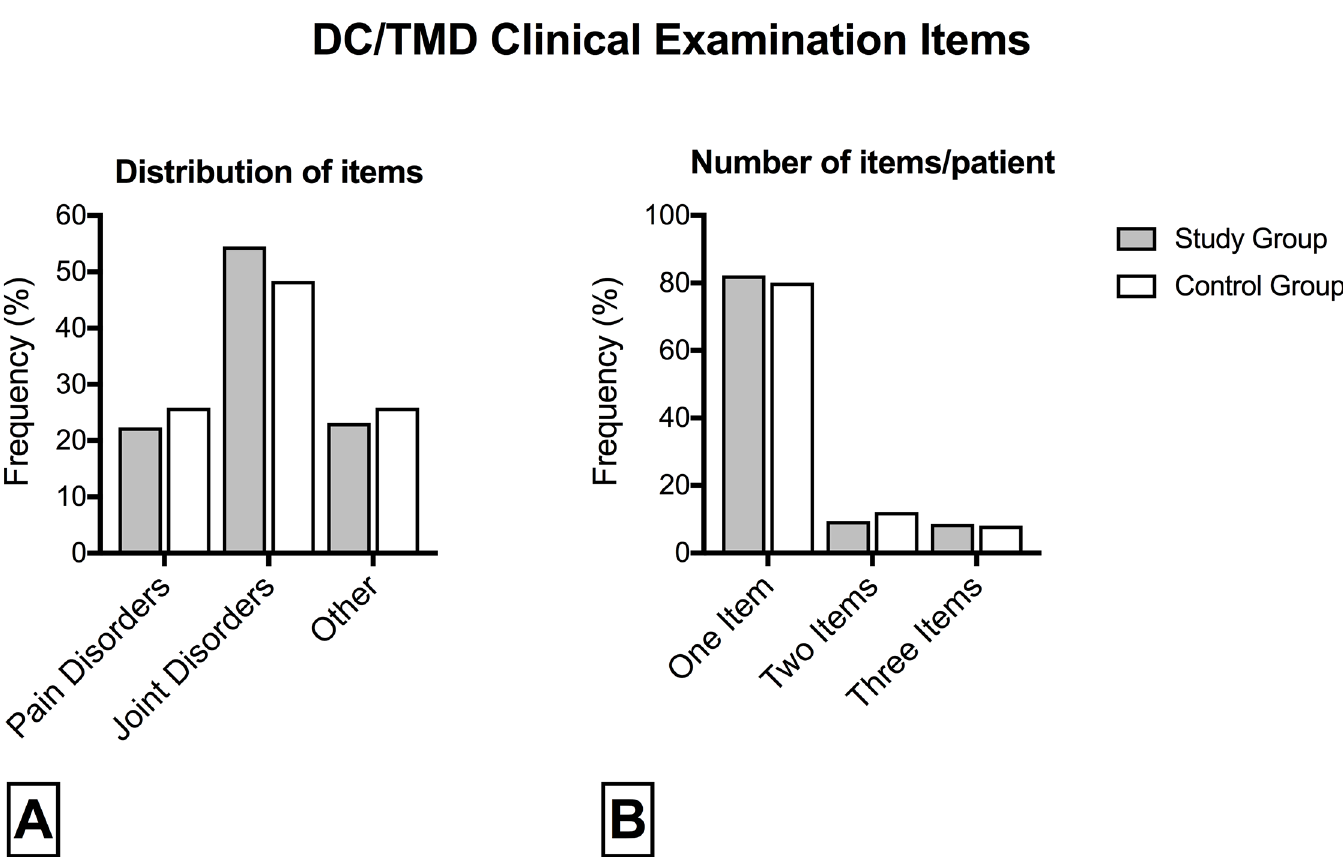
Fig 4. Temporomandibular joint (TMJ) disorders classification according to Diagnostic Criteria for Temporomandibular Disorders (DC/TMD) Axis I. (A) Distribution of items: most patients had joint disorders (67.2%), followed by other (29.8%) and pain disorders (29%). (B) Number of items per patient: most patients (81.6%) had only one clinical examination item; two or three concomitant items were found in 18.4% of patients. No significant differences were found between patients in the study and control groups.